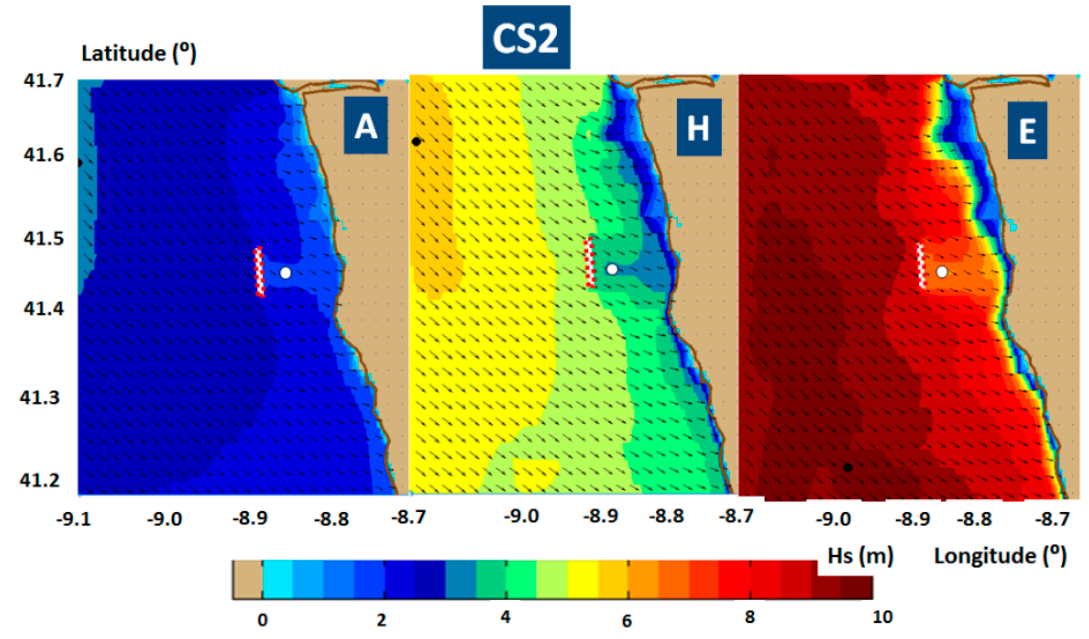
Figure 6. CS2 (realistic scenario for the wave farm), results of the SWAN model simulations. The significant wave height scalar fields are illustrated in the background, while in the foreground the wave vectors. A—average wave conditions, H—high wave conditions, E—extreme wave conditions.